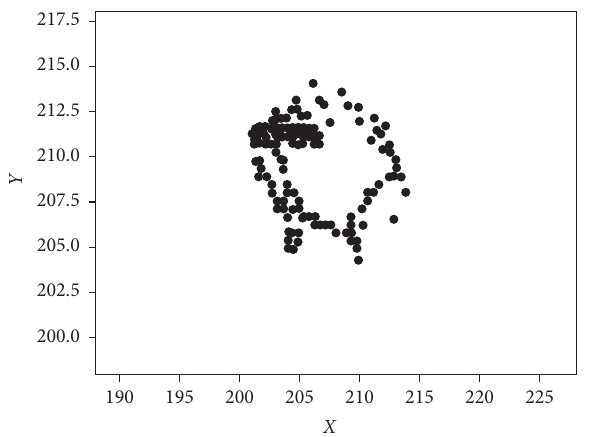
Figure 8: Facial motion feature point